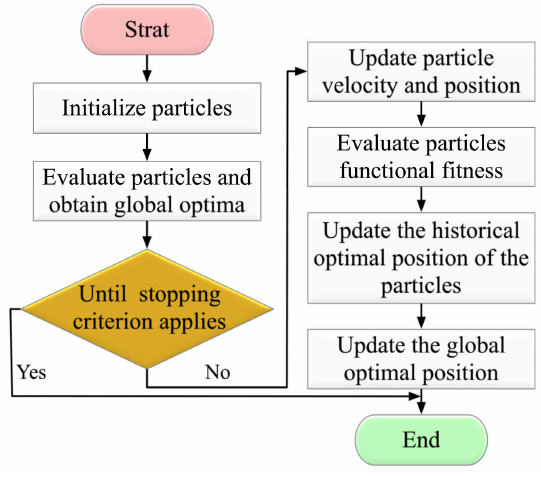
Figure 5. Particle swarm optimization